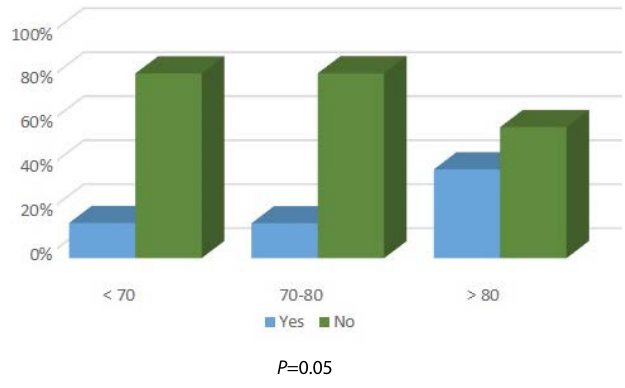
Fig. 2 - Blood transfusion during hospitalization by age group, P=0.04.